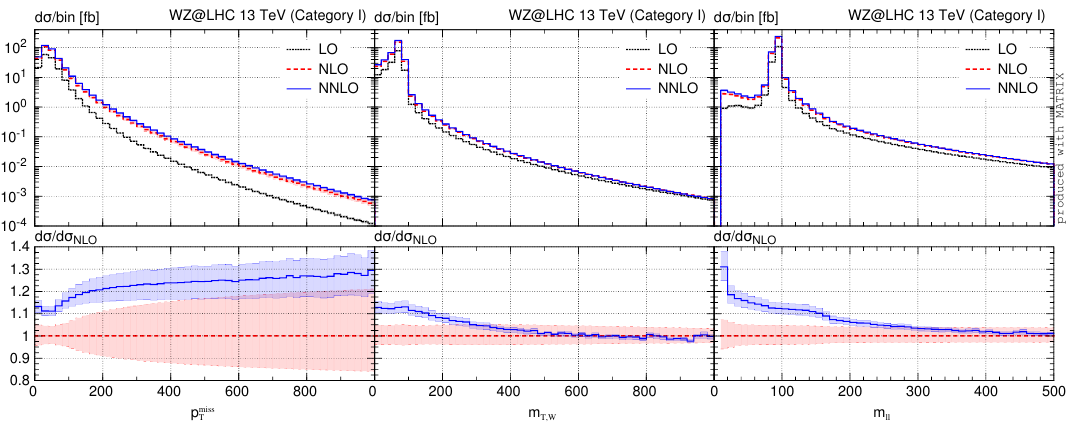
Figure 14 . Distributions with respect to p miss phase space without additional cuts (Category